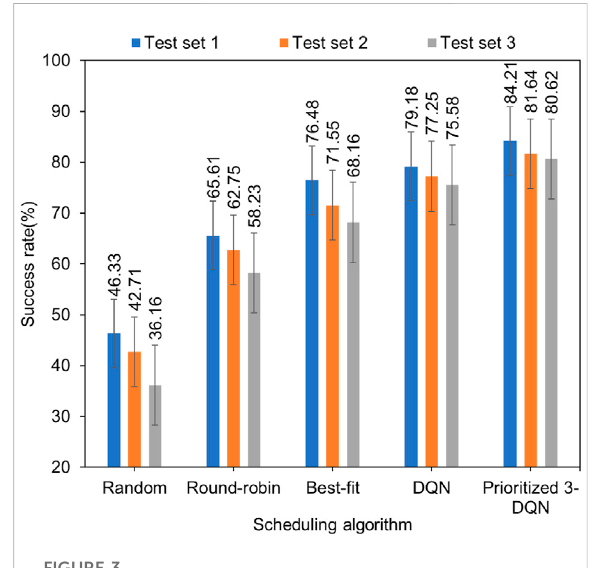
FIGURE 3 Comparison chart of composite services success rate with standard